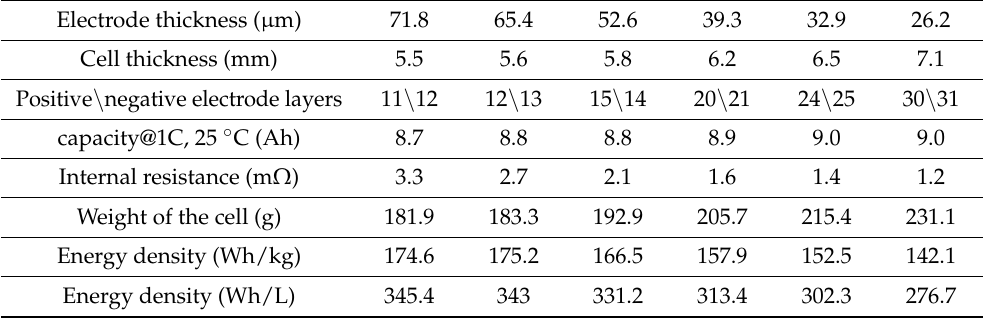
Table 3. Size and basic performance information of pouch cell.